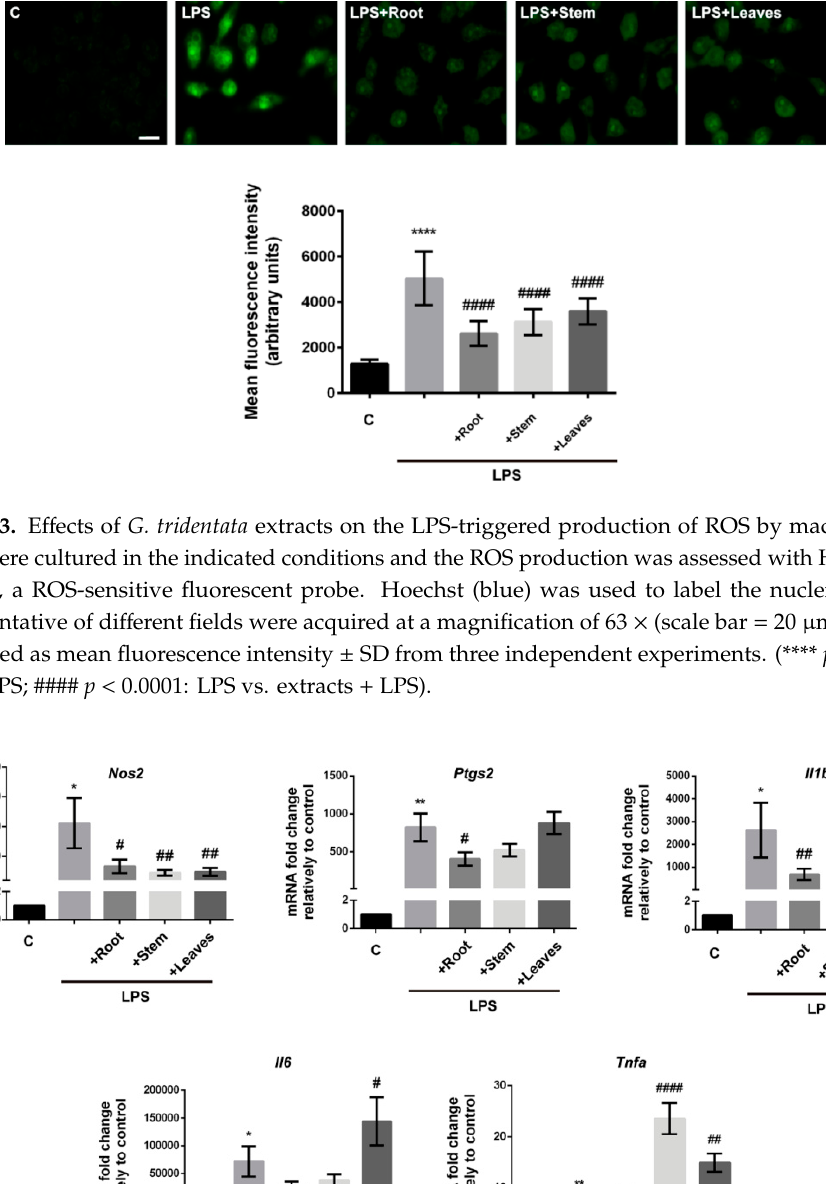
( b ) Figure 2. Evaluation of the capacity of G. tridentata extracts to modulate NO production in Raw 264.7 macrophages. ( a ) Levels of NO in supernatants from cells stimulated with extracts or with extracts and LPS. ( b ) Assessment of the potential of NO scavenging activity through the SNAP assays. Data is presented as concentration of NO and represent mean ± SD from three independent biological experiments. (**** p < 0.0001: control vs. LPS; #### p < 0.0001: LPS vs. extracts + LPS). Data is presented as percentage of control (nontreated cells/medium) and represent the mean ± SD from at least three independent experiments. The pre-treatment of macrophages with extracts also significantly reduced cellular ROS levels resultant from LPS stimulation (Figure 3). This observation directly relies on the well-established